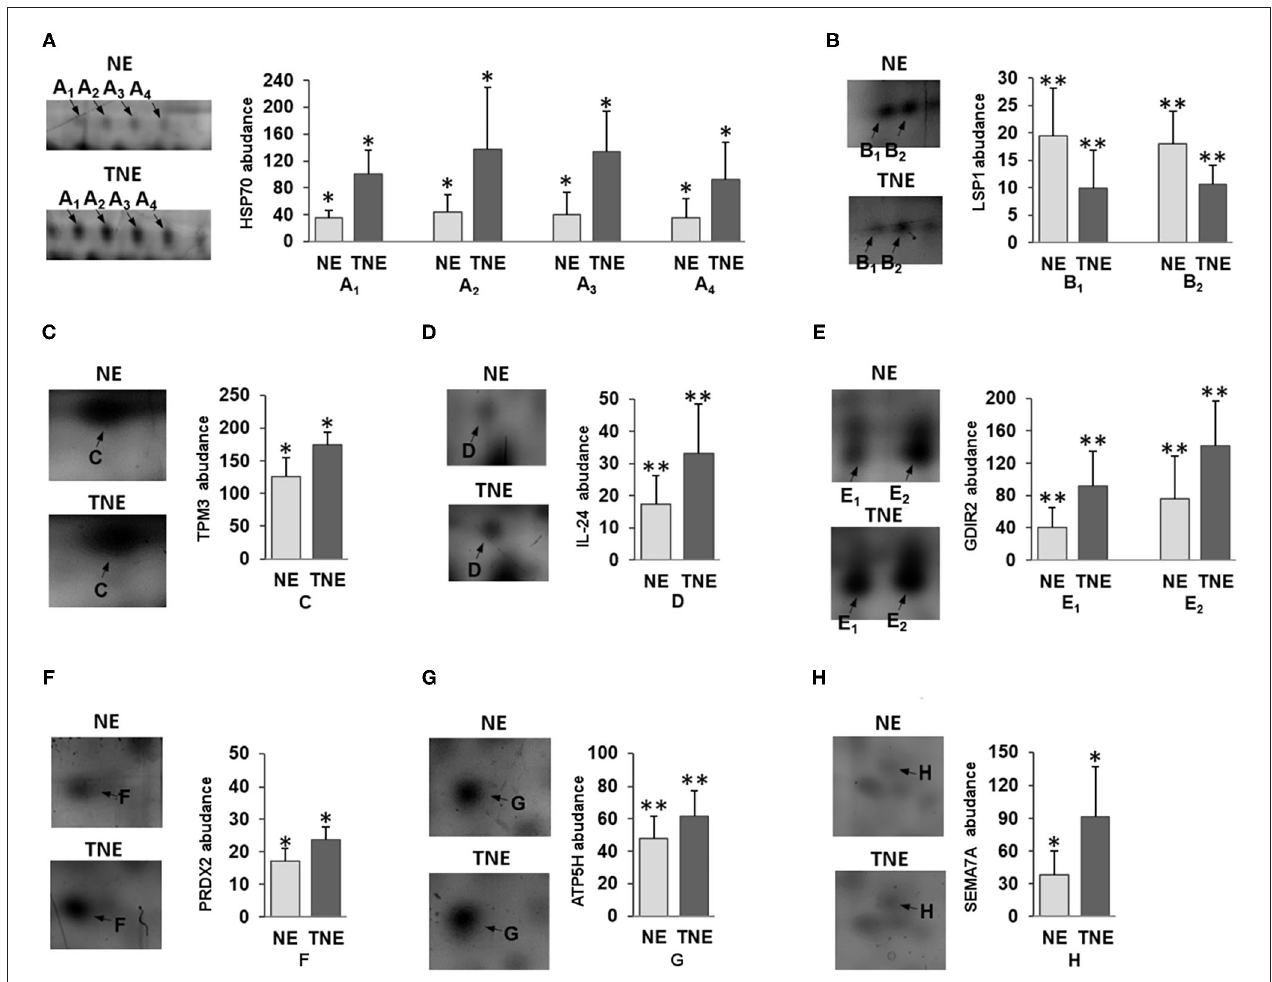
FIGURE 5 | The graphic trend for spots with a variable expression of (A) HSP70, (B) LSP1, (C) TPM3, (D) IL-24, (E) GDIR2, (F) PRDX2, (G) ATP5H and (H) SEMA7A proteins between TNE (dark gray bars) and NE group of mice (light gray bars). The data concerning the protein expression are given as arithmetic mean with SD (group n = 6). Student’s t -test * p < 0.05, ** p <